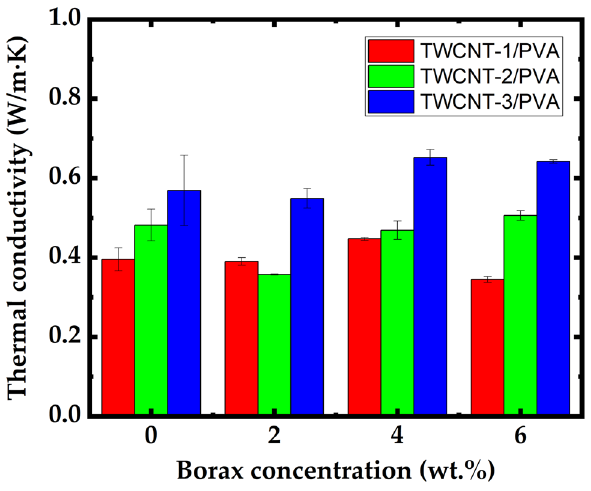
Figure 4. Comparison of thermal conductivities of TWCNT/PVA for (TWCNT-1, TWCNT-2, and TWCNT-3) at various concentrations of borax (0, 2, 4, and 6 wt.%).